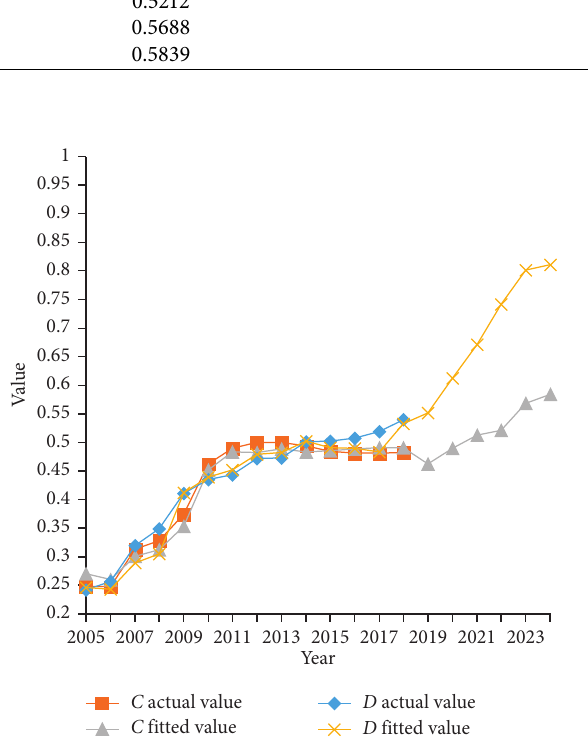
Figure 2: Trends in the predictive